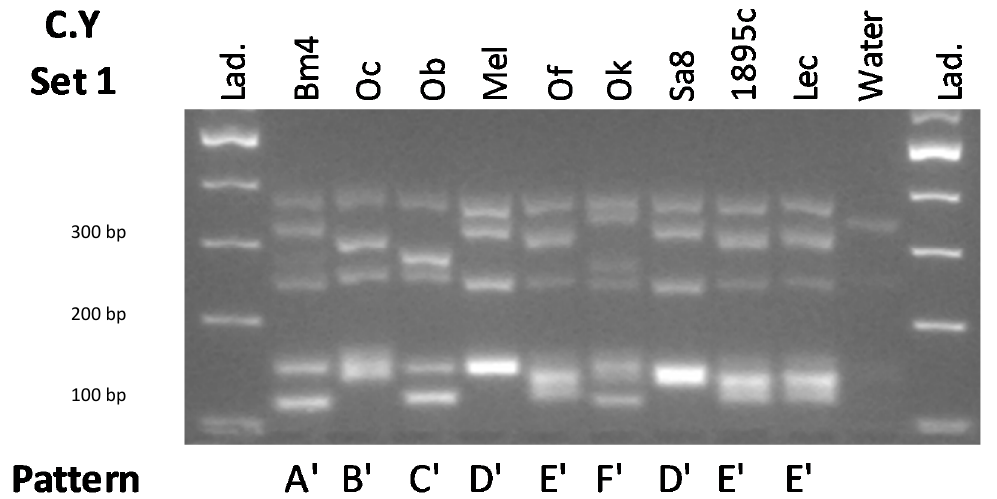
Figure 2. Results of the gel electrophoresis for the commercially available yeasts named above after multiplex PCR using Multiplex Set 1 with the nomenclature of the patterns A–F.